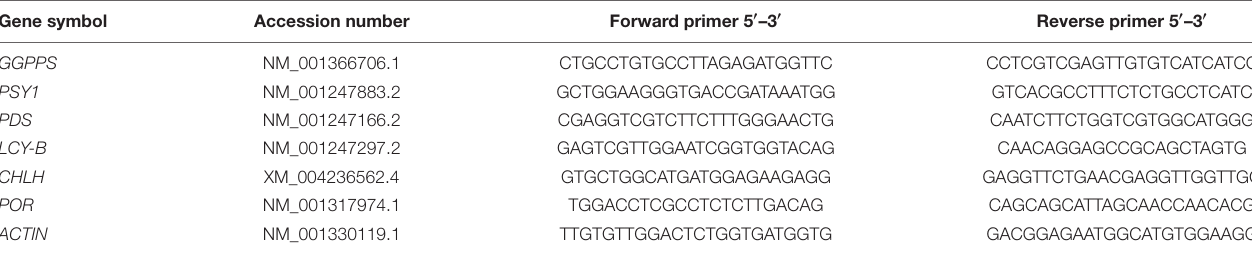
TABLE 1 | Primer sequences and GenBank accession numbers of the geranylgeranyl diphosphate synthase ( GGPPS ), PSY1 , phytoene desaturase ( PDS ), lycopene β -cyclase ( LCY-B ), CHLH , POR , and ACTIN gene sequences. Gene